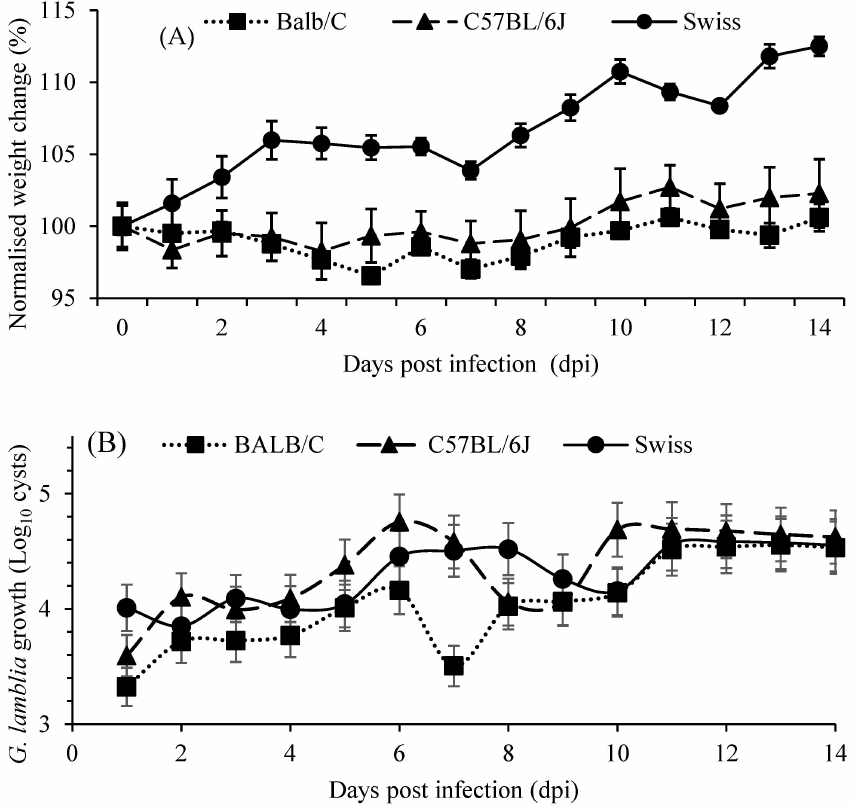
Figure 1. ( A ) Weight, relative to day zero of mice during infection and ( B ) G. lamblia colonisation, from faecal shedding, during